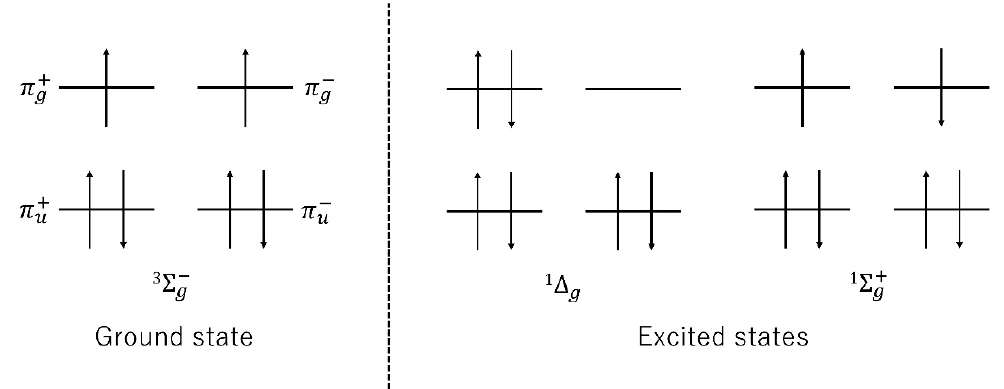
Figure 1. Electron configuration of the 𝜋 orbitals of the oxygen molecule.